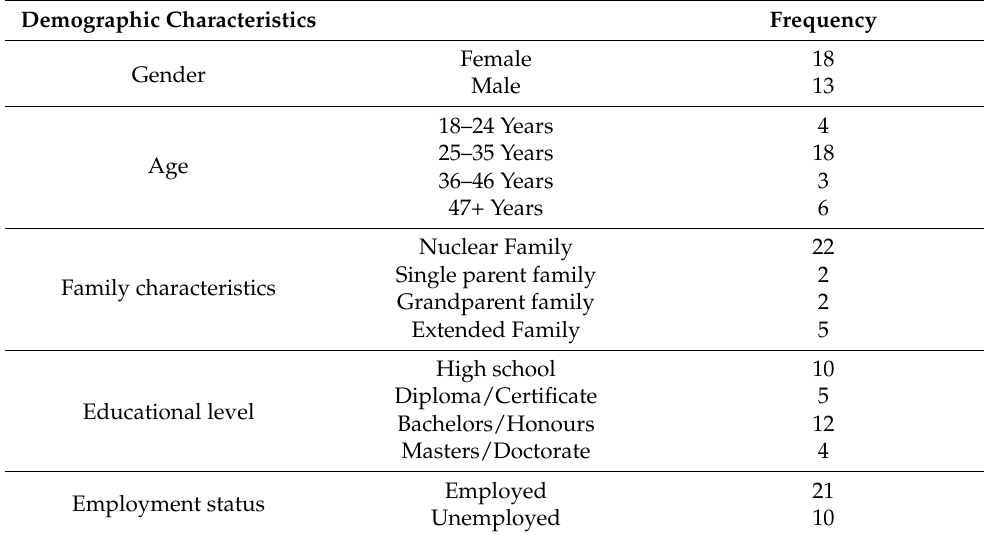
Table 1. Demographic